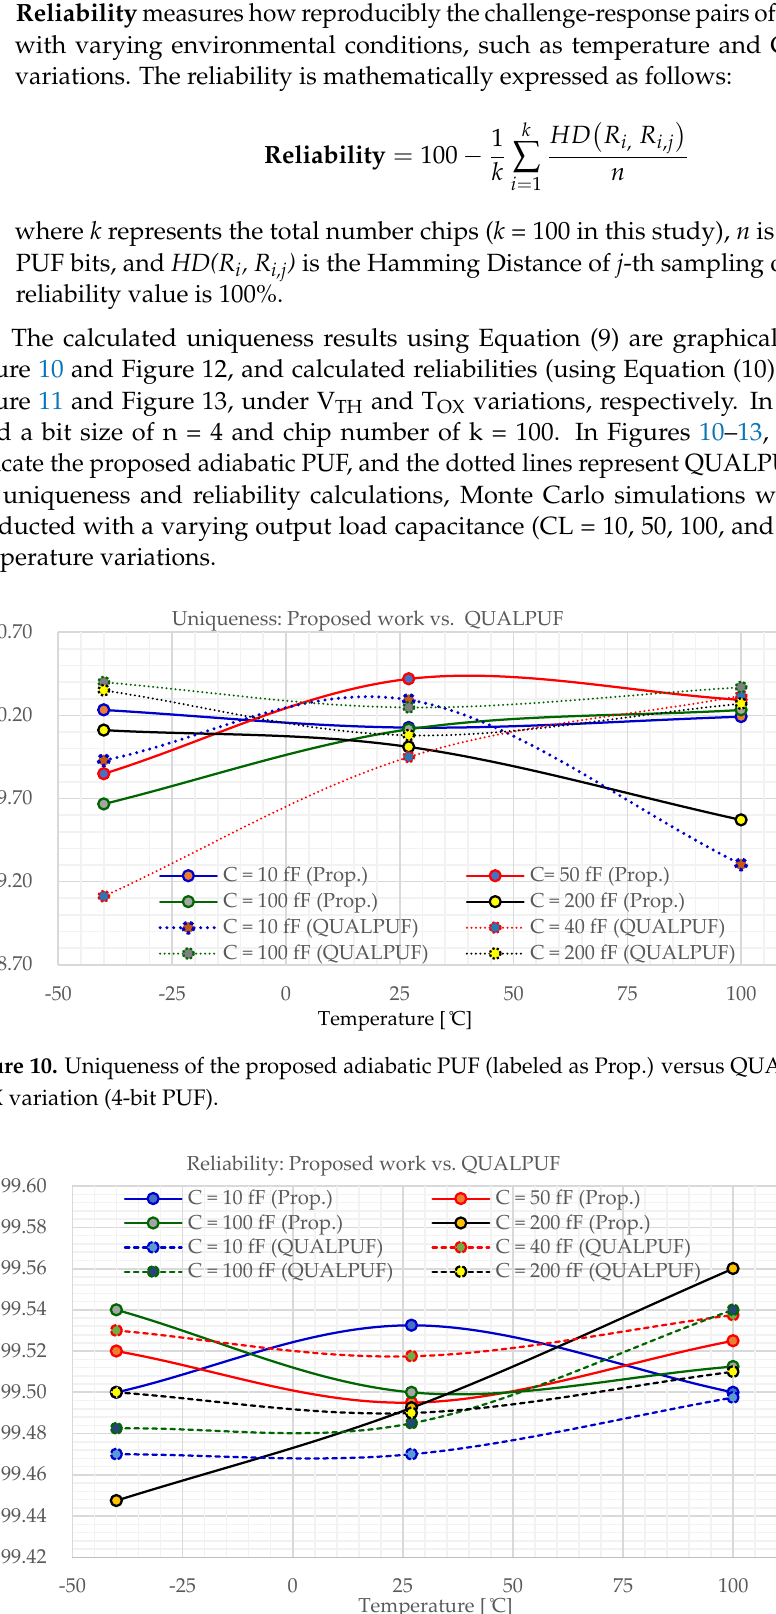
Figure 11. Reliability of the proposed adiabatic PUF (labeled as Prop.) versus QUALPUF under the TOX variation (4-bit PUF).